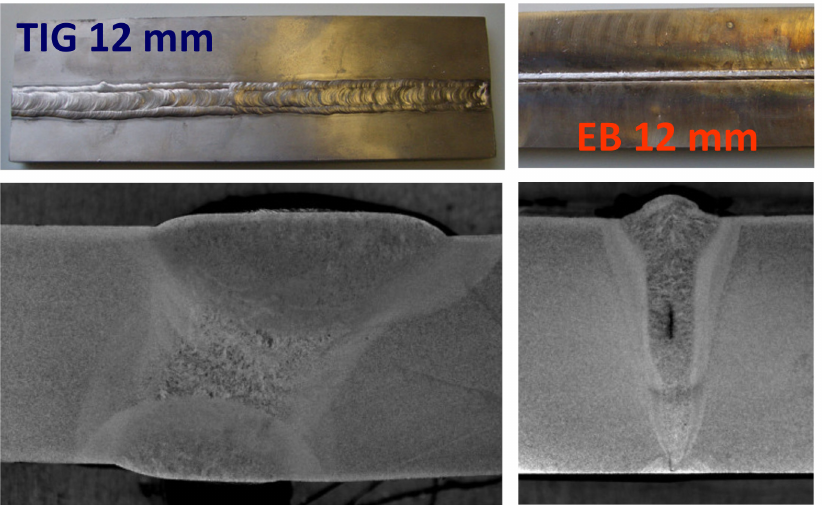
Figure 10. ( Lower row ) 12 mm 1 -V tungsten inert gas (TIG) weld and 12 mm electron beam (EB) 2 weld with beam stopper; ( upper row ) look on the weld lines from